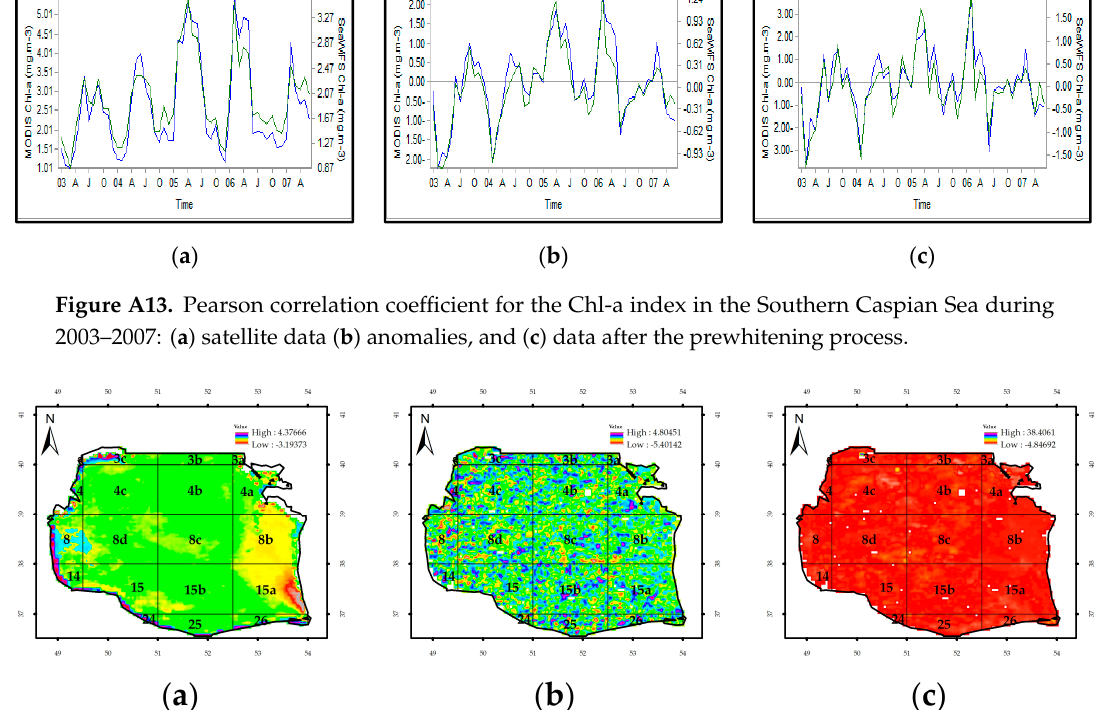
Figure A14. Z-score statistics for the Chl-a concentration in the Southern Caspian Sea from 2003 to 2007: ( a ) satellite data, ( b ) anomalies, and ( c ) data after the prewhitening process.